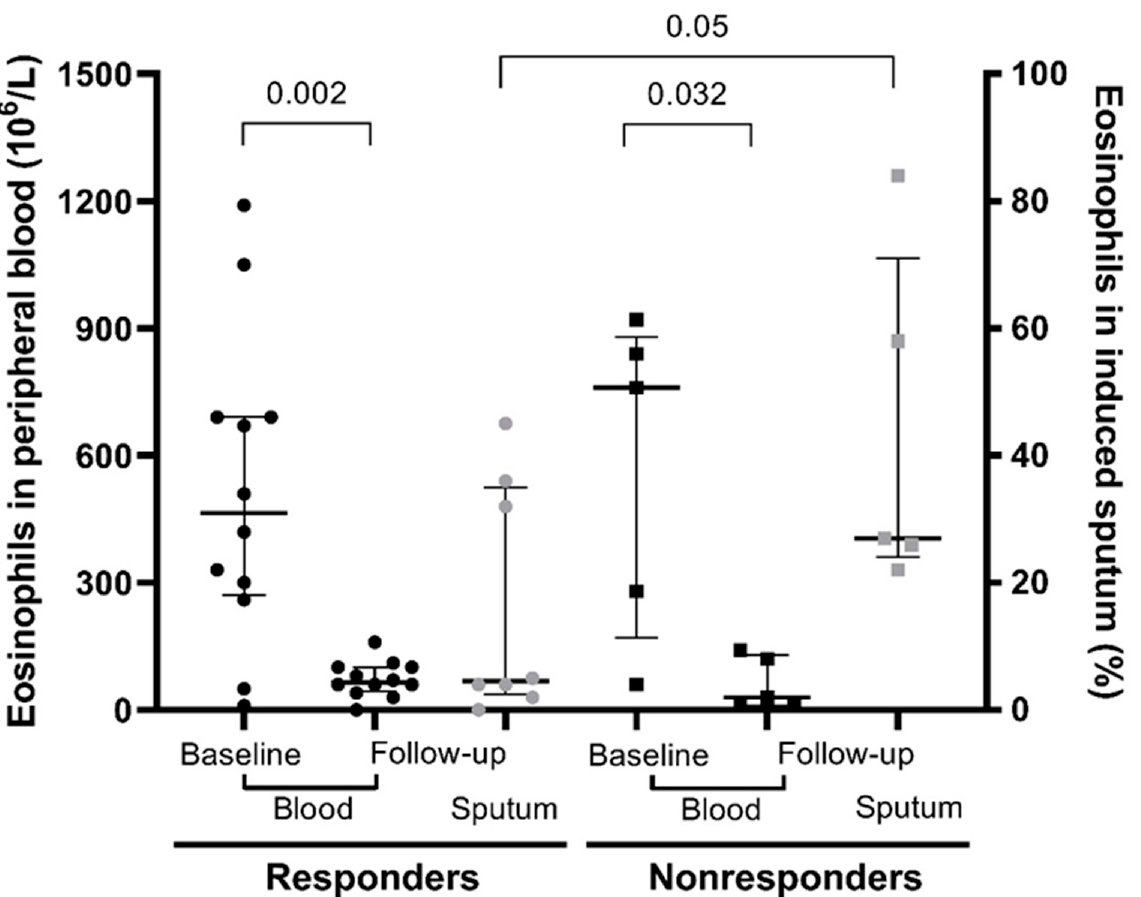
Figure 1. Differences in blood and sputum eosinophils between the two groups at baseline and at the week 16 follow-up.